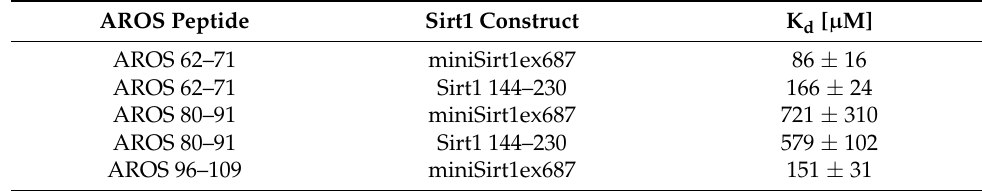
Table 2. K d of Sirt1 interactions with AROS